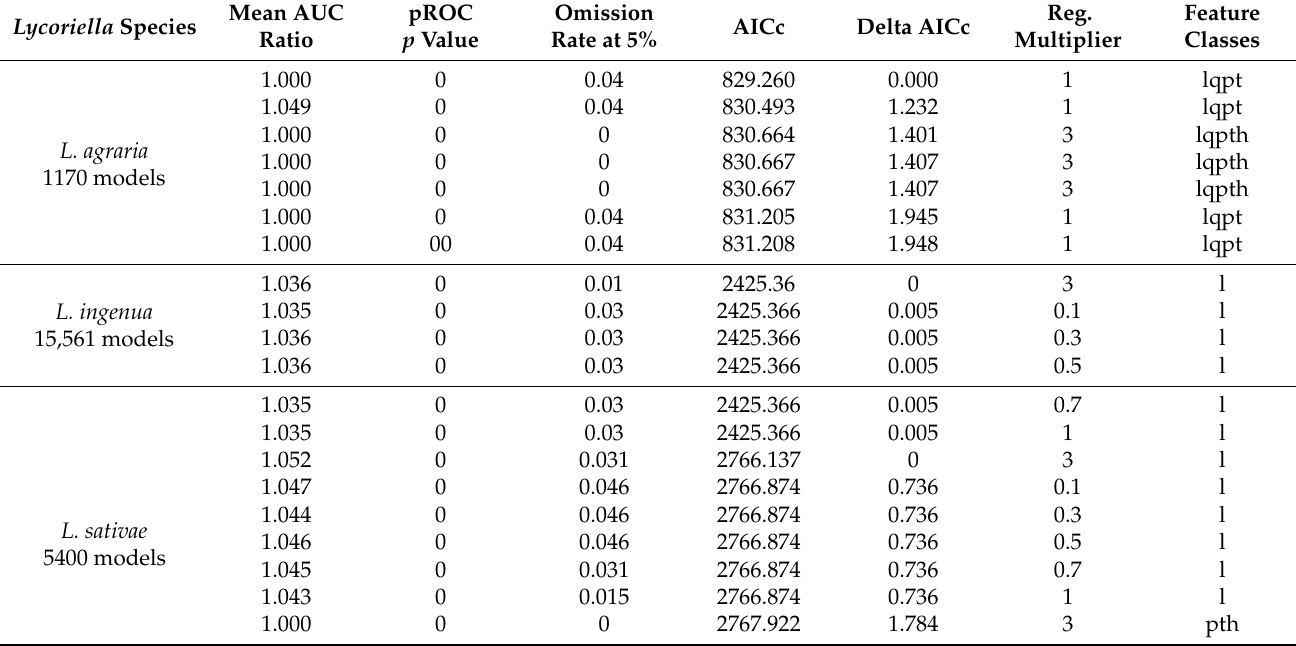
Table 1. Best models selected and evaluated based on statistical significance (partial ROC), performance (omission rates: OR), and complexity (AICc). This model was calibrated and projected using the environmental variables shown in Table 2. Lycoriella Species